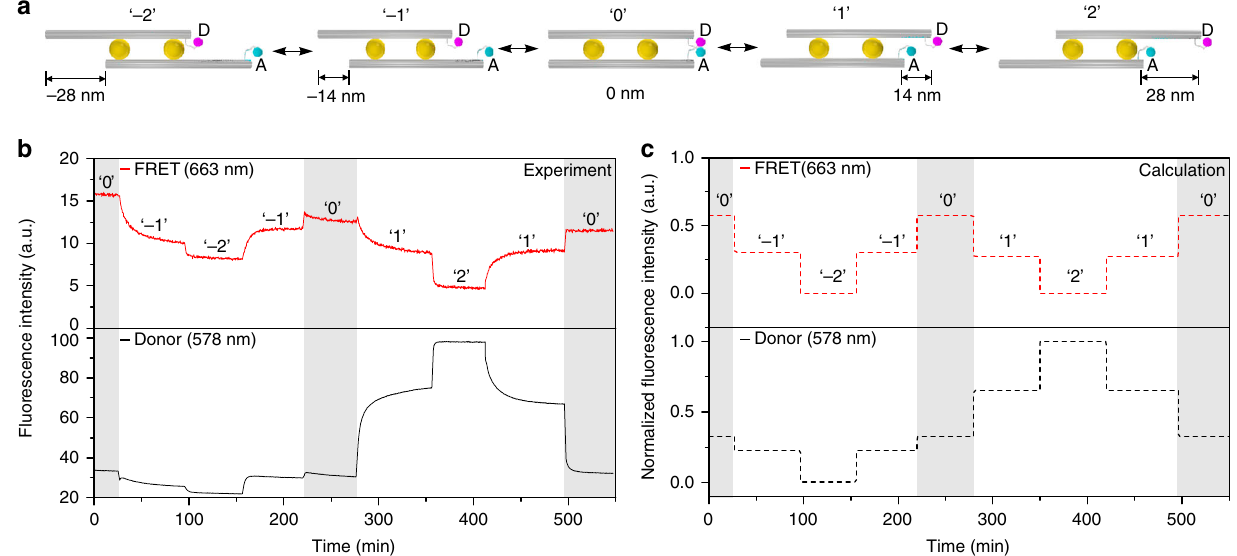
Fig. 3 AuNC-mediated relative sliding monitored by in situ fl uorescence spectroscopy. a Schematic of the fi ve sliding states ‘– 2, ’ ‘– 1, ’ ‘ 0, ’ ‘ 1, ’ and ‘ 2. ’ D and A represent donor and acceptor, respectively. b Experimental FRET and donor fl uorescence signals monitored at wavelengths of 663 nm and 578 nm, respectively, with excitation wavelength of 530 nm. c Theoretical calculation including both FRET between the fl uorophores and electromagnetic quenching of the fl uorophores by the